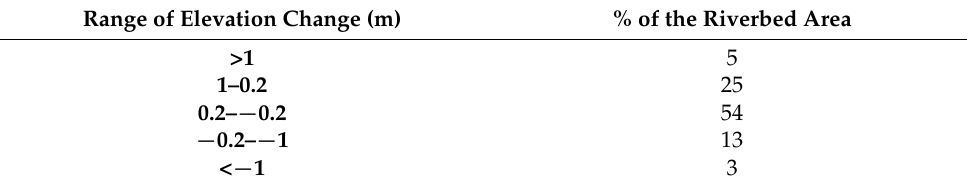
Figure 8. Differences between the digital terrain models (DTMs) obtained in 2018 and 2017. Details of the areas in the red frames are presented in Figure 9. At this stage, vegetation is not considered. Table 3. Elevation changes across the riverbed. At this stage, vegetation was not considered.